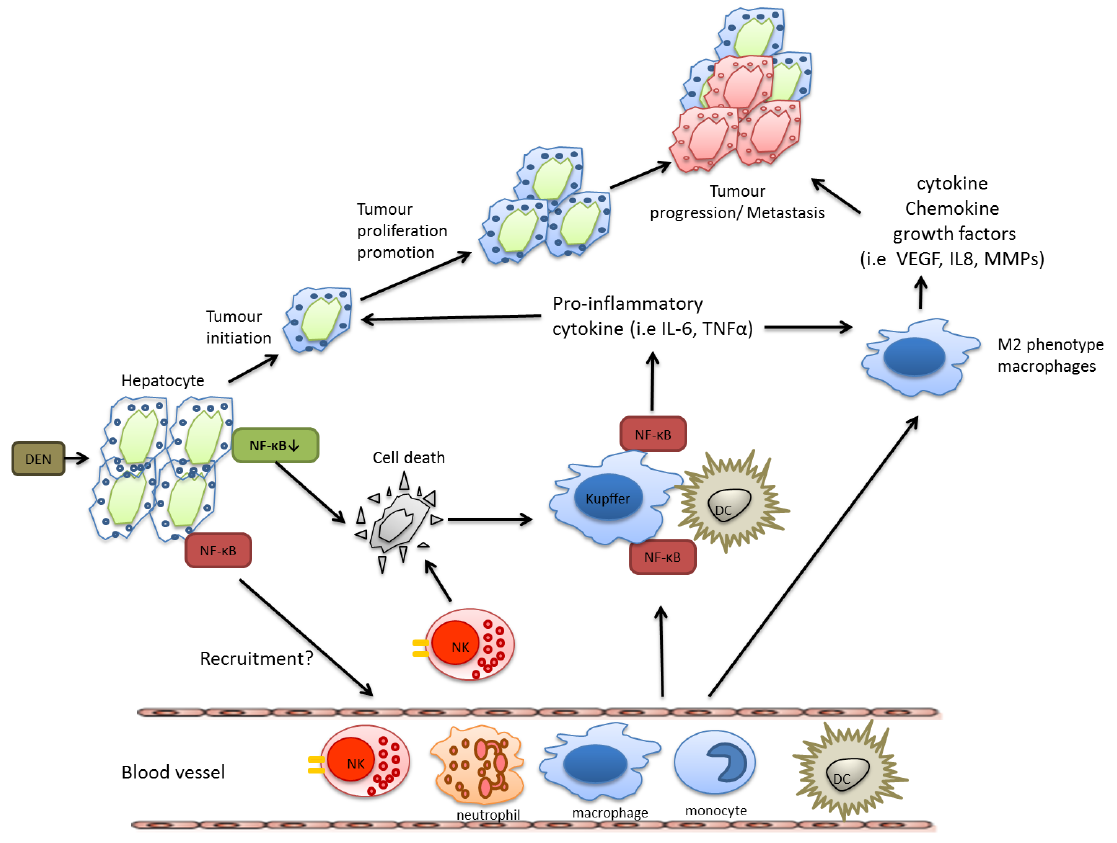
Figure 2. In IKK  -deficient hepatocytes, necrotic cell death of DEN-exposed hepatocytes is augmented leading to the release of pro-inflammatory factors triggering IKK-β and NF-κB signaling in adjacent myeloid cells, which release pro-inflammatory cytokines and hepatomitogens that ultimately promote growth of DEN-initiated